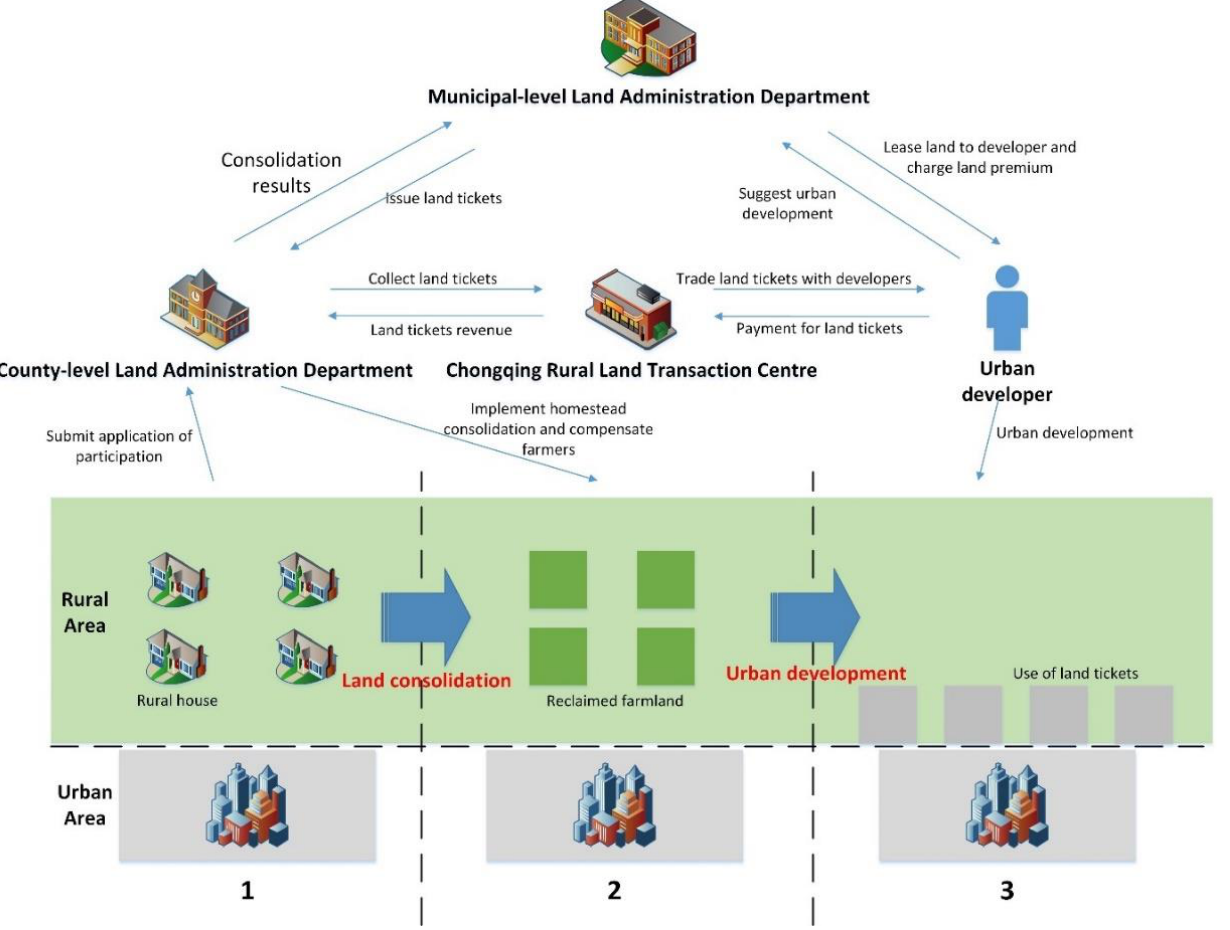
Figure 2. Land Ticket Program transaction process.